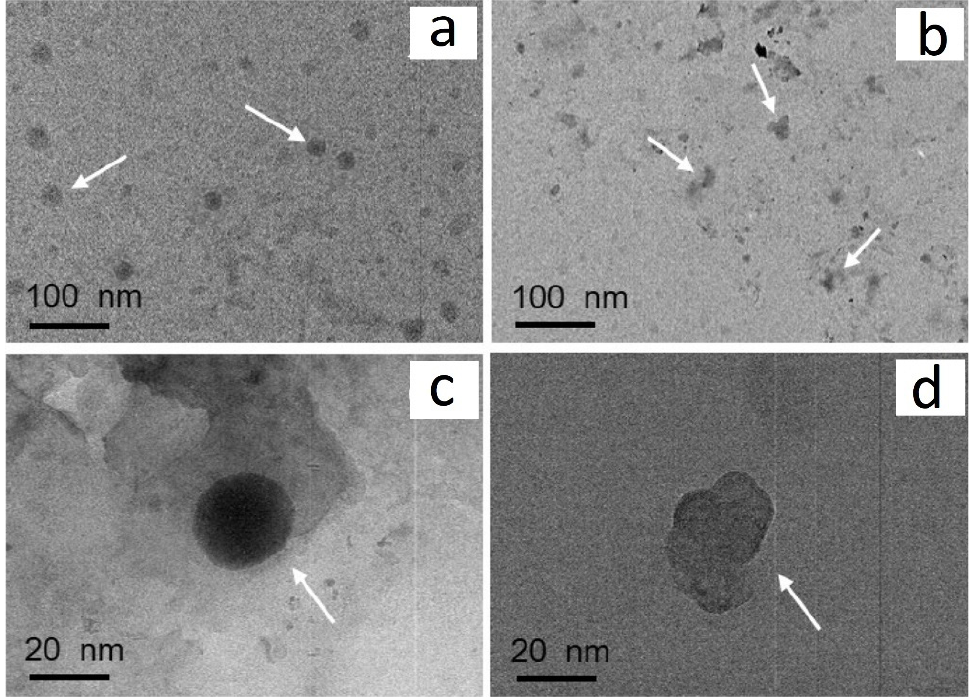
Figure 21. TEM images of phage MS2 before ( a , b ) and after ( c , d ) treatment with g-C 3 N 4 for 6 h under visible-light irradiation. Used with permission from [198]. Copyright 2016